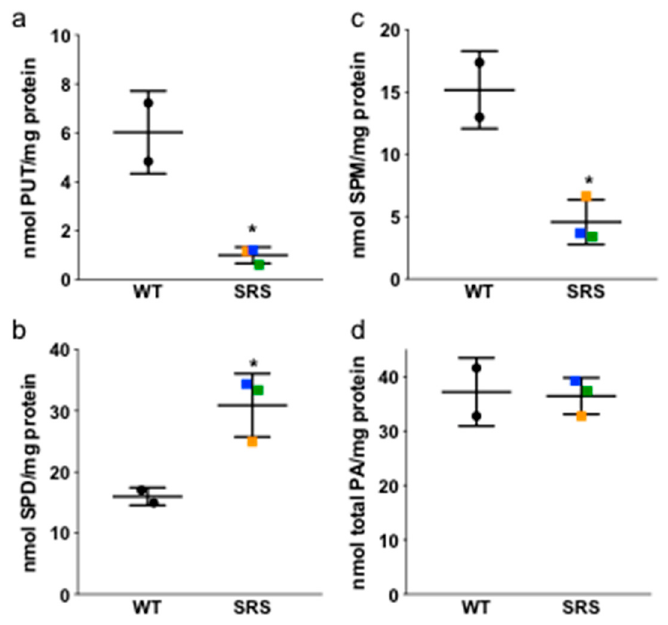
Figure 2. Alterations in basal intracellular concentrations of ( a ) putrescine (PUT), ( b ) spermidine (SPD), ( c ) spermine (SPM), and ( d ) total polyamines (PA) between SMS wildtype (WT) or mutant (SRS) lymphoblast cell lines ( n = 5, each measured in duplicate). Concentrations are presented as nmol of polyamine per mg of cellular protein. The individual SRS cell line designations are orange for SRS1, blue for SRS2, and green for SRS3. Error bars indicate standard error of the mean (SEM). * p < 0.05.